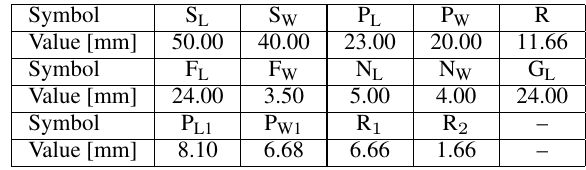
10 . 60 GHz, respectively. The designed antenna has to gain variations from 1 . 1 − 3 . 3 dBi over the entire resonating band.